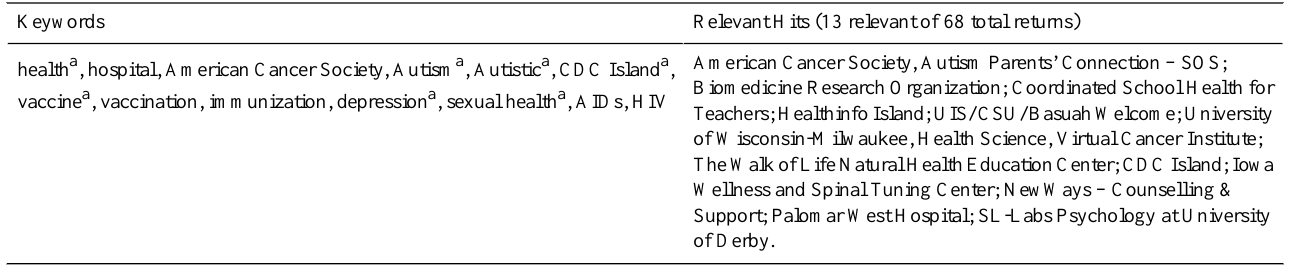
Table 1. Search results using a variety of test keywords in the Second Life search engine